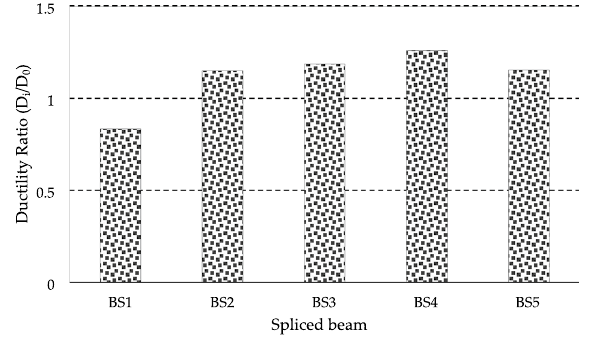
Fig. 7 Influence of spliced length on beam ductility